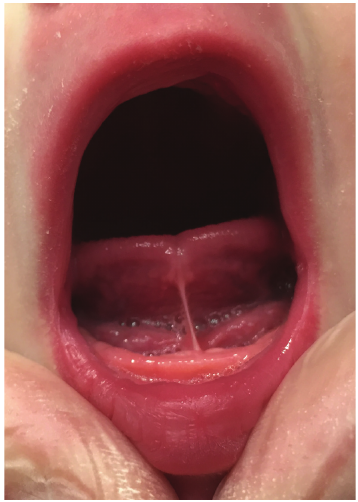
Figure 1: Lingual frenum with degree II